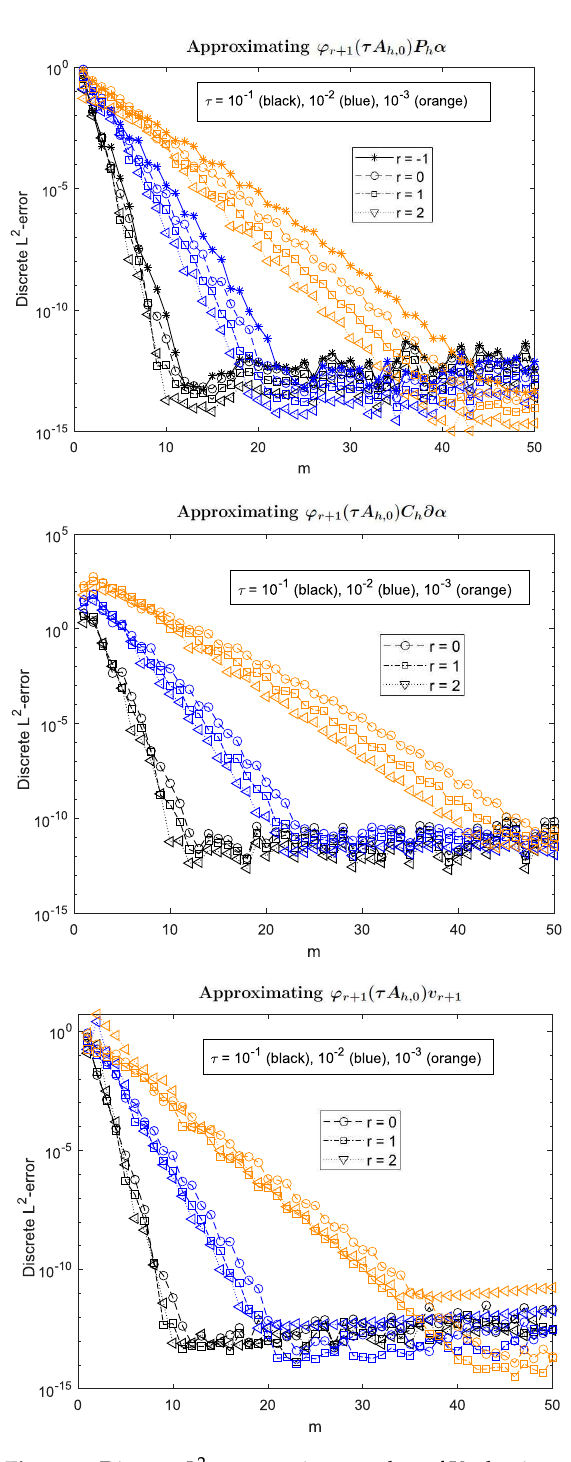
Figure 8. Discrete L 2 -error against number of Krylov iterations when approximating ϕ r + 1 ( τ A h ,0 ) P h α , ϕ r + 1 ( τ A h ,0 ) C h ∂α , ϕ r + 1 ( τ A h ,0 ) v r + 1 for the data in Section 2.1 through purely rational Krylov methods for different values of τ , r = 0,1,2, and fixed h = 10 − 3